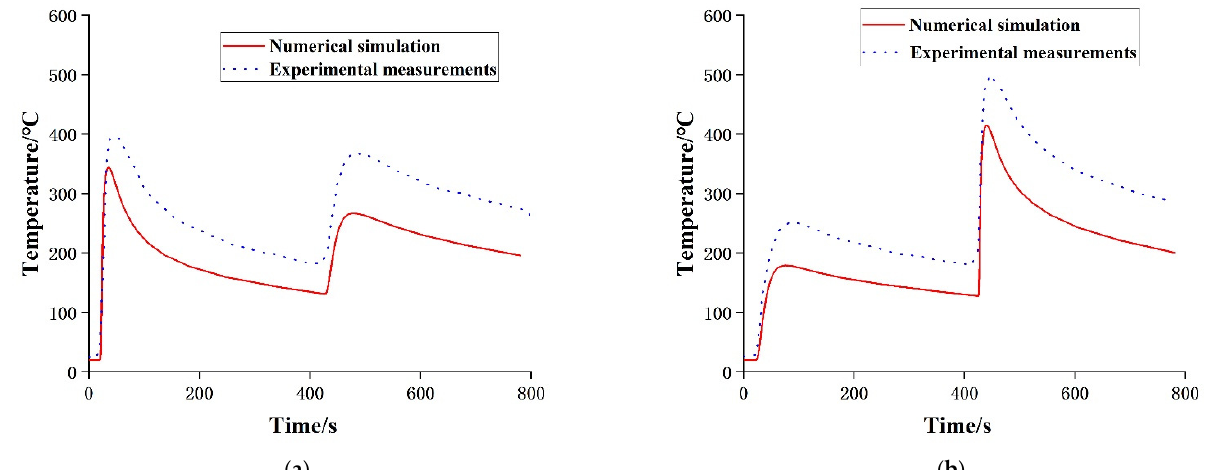
Figure 5. Temperature–time histories at the nodes: ( a ) Point 1; ( b ) Point 2.